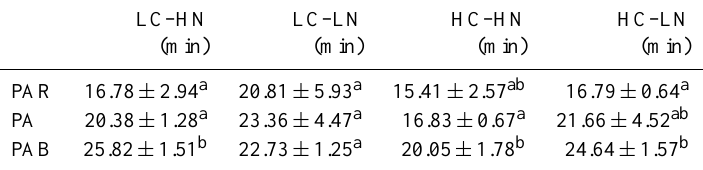
Table 4. The recovery time to half maximal yield values under growth light after 60min exposure to solar radiation with or without UV. Different letters of superscripts indicate significant differences between the radiation treatments at P< 0 .